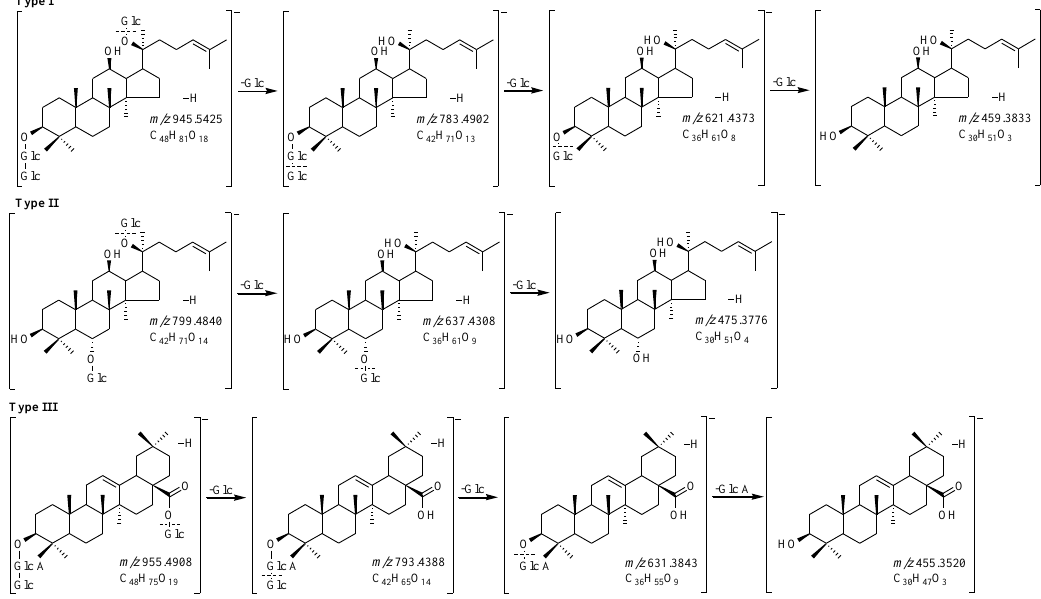
Figure 1. The fragmentation pathways of different types of ginsenosides: Type I [(20 S )- protopanaxadiol], Type II [(20 S )-protopanaxatriol], and Type III (oleanolic acid).